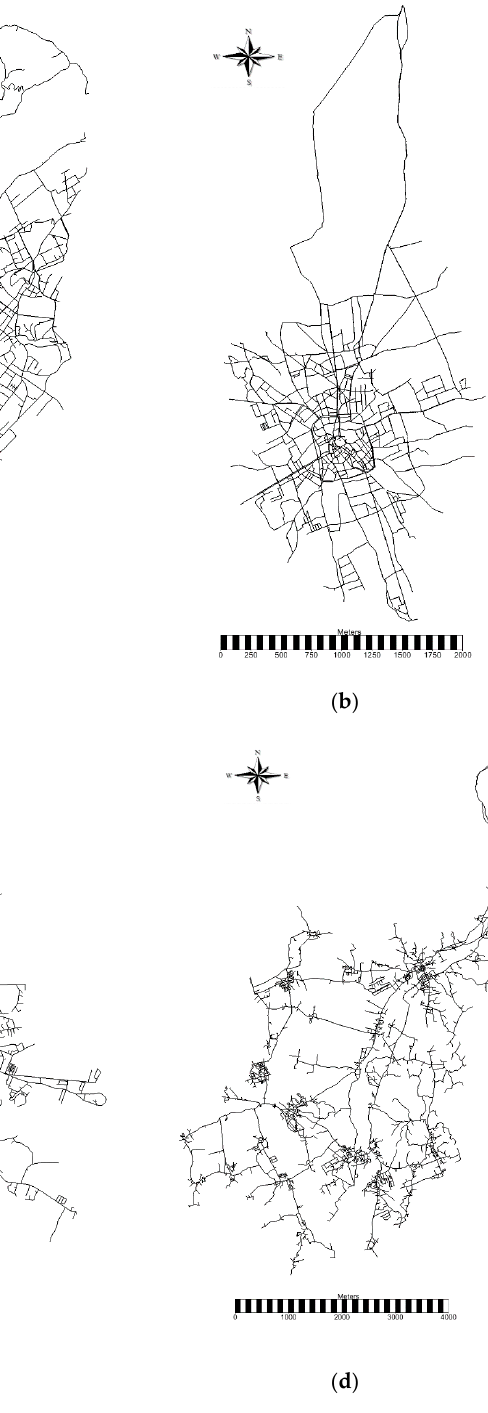
Figure 2. Layout of the four real systems adopted in the numerical analyses: ( a ) G water distribution system (WDS); ( b ) U WDS; ( c ) T WDS; ( d ) P WDS. The first three supply medium-sized cities, while P WDS supplies twelve small towns.